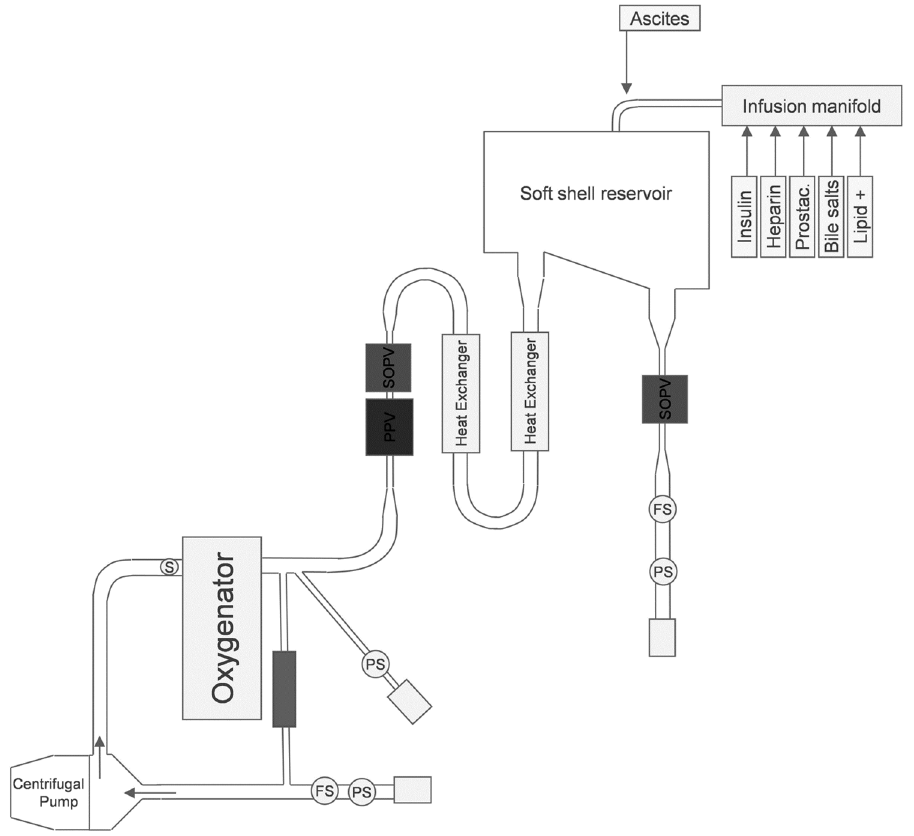
Fig 1. Diagram of perfusion circuit. Key: SOPV: Shut-off pinch valve, PPV: Proportional pinch valve, Shunt S.: Terumo Shunt Sensor, PS: Pressure Sensor, S: Sampling port, FS: Flow sensor. (Illustrationnot to scale).